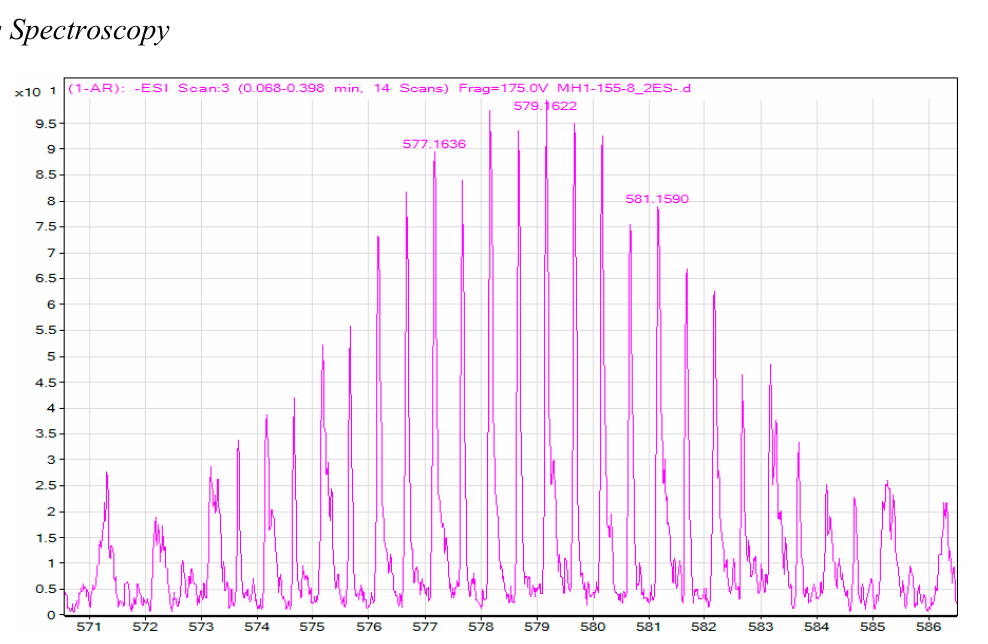
Figure A1. Mass Spectrum of Compound ( 1-L4 ) (M 2 − , m / z = 579.16). ESI mass spectrometry was performed in acetonitrile in negative ion